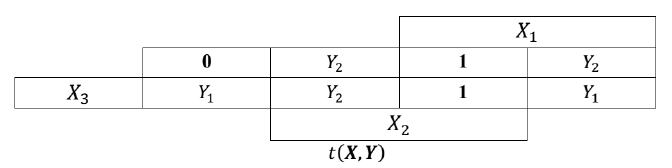
Fig. 4. VEKM representation for 𝒕(𝑿, 𝒀) in the Example in Sec.